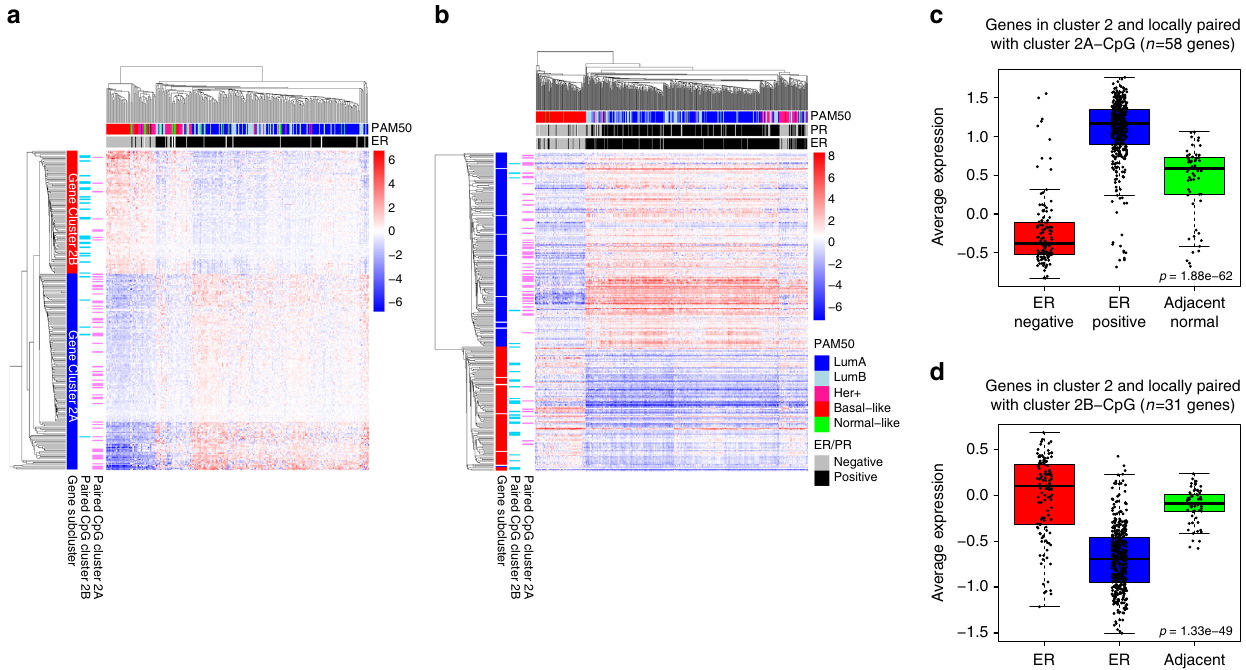
Fig. 4 Differential expression of genes in Cluster 2. Unsupervised clustering of expression of the genes in Cluster 2 for ( a ) the OSL2 cohort ( N = 272) and ( b ) the TCGA cohort ( N = 528). Genes in rows are annotated if they are locally paired with CpG in Cluster 2 A ( pink ) or paired with CpG of Cluster 2B ( light blue ). Two main sub-clusters of genes are identi fi ed in the heatmap in a , and the genes in the heatmap in b are annotated correspondingly. Annotations of the column of the heatmap indicate histopathological features of the patients: PAM50 subtype, ER and PR status. c – d Average expression of genes in Cluster 2 locally paired with CpGs in Cluster 2 A ( n = 58) and Cluster 2B ( n = 31). A gene was considered to be locally paired with a CpG if it was situated not more than 10 kb from this CpG. Average expression in ER positive tumors ( blue ; n = 406), ER-negative tumors ( red ; n = 117) and adjacent normal tissue ( green ; n = 61) from the TCGA cohort. Kruskal – Wallis test p -values are denoted